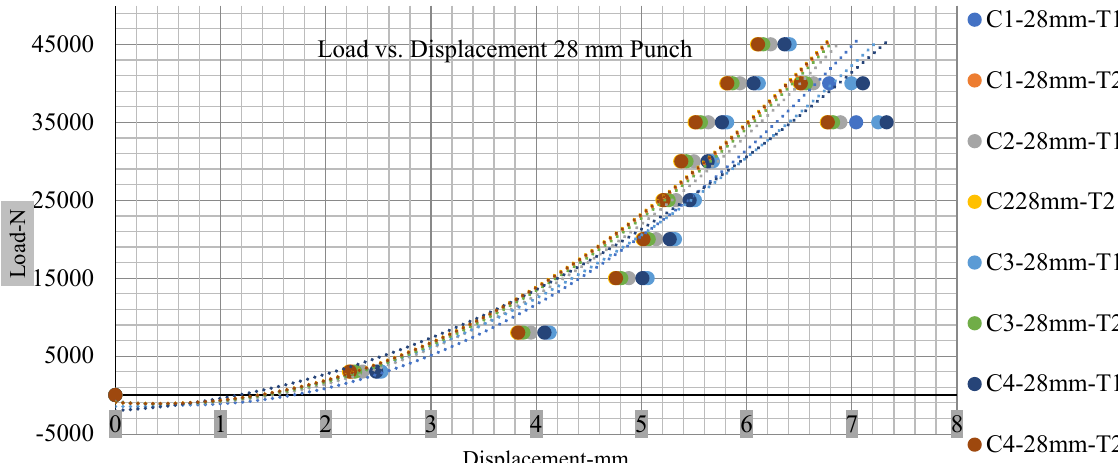
Figure 16. Load vs. displacement 28 mm low to peak loads.